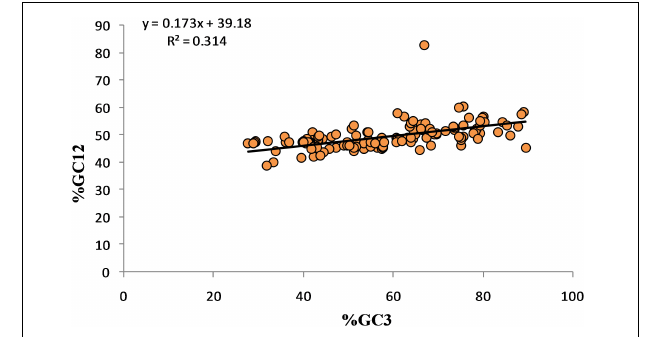
FIGURE 8 | Neutrality plot analysis revealed 17.25% mutational forces and 82.68% selection forces acting on 60 genes related to neurodegenerative